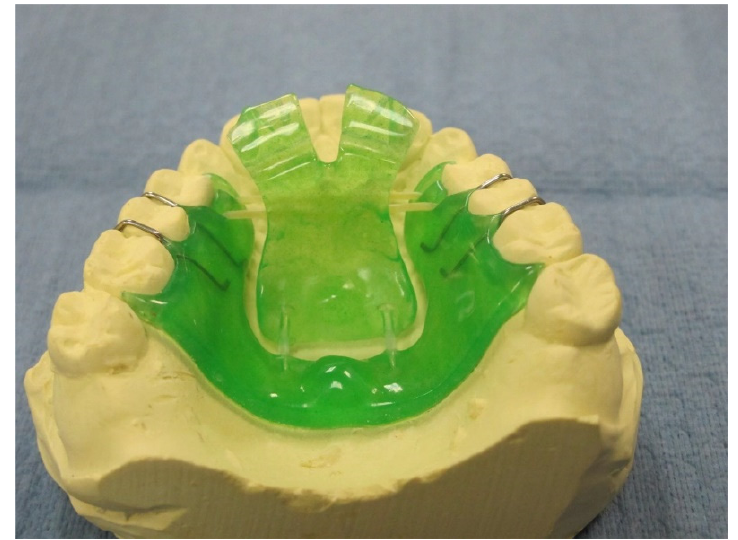
Figure 1. Oral muscle training